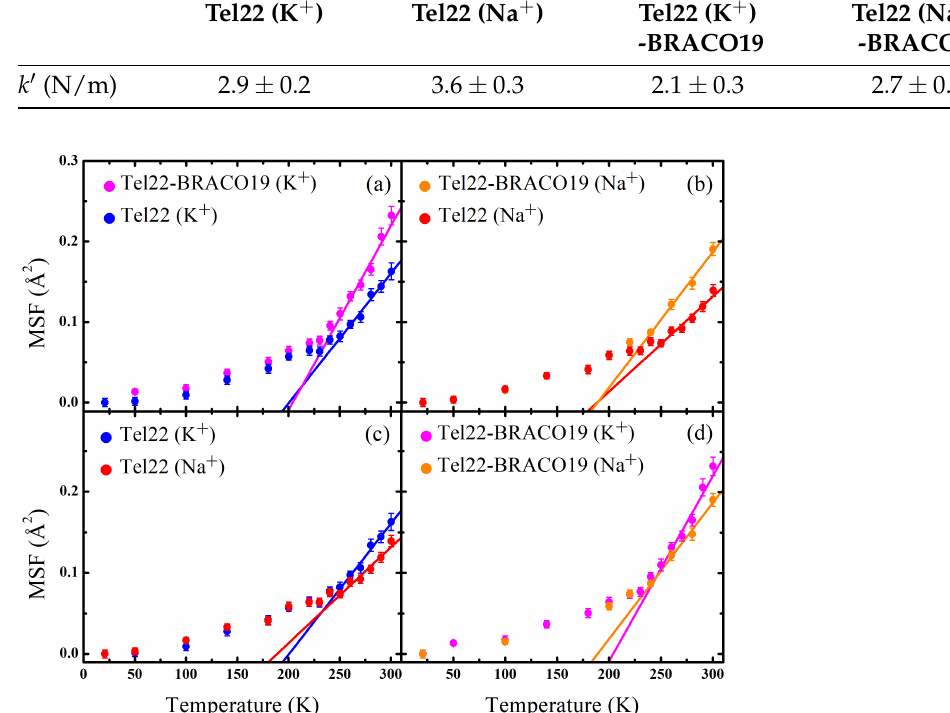
Figure 3. Mean Square Fluctuations (MSF) as a function of temperature for Tel22 (K + ), Tel22 (Na + ), Tel22-BRACO19 (K + ), and Tel22-BRACO19 (Na + ) along with the best fit to data (solid lines) using Equation